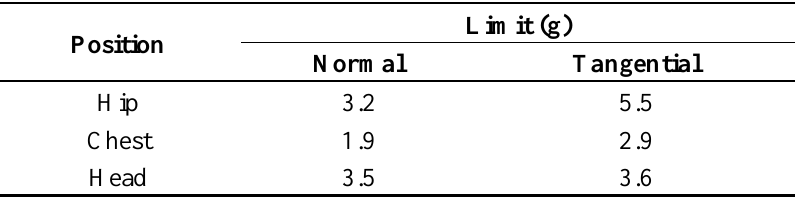
Table 3. Acceleration limits.